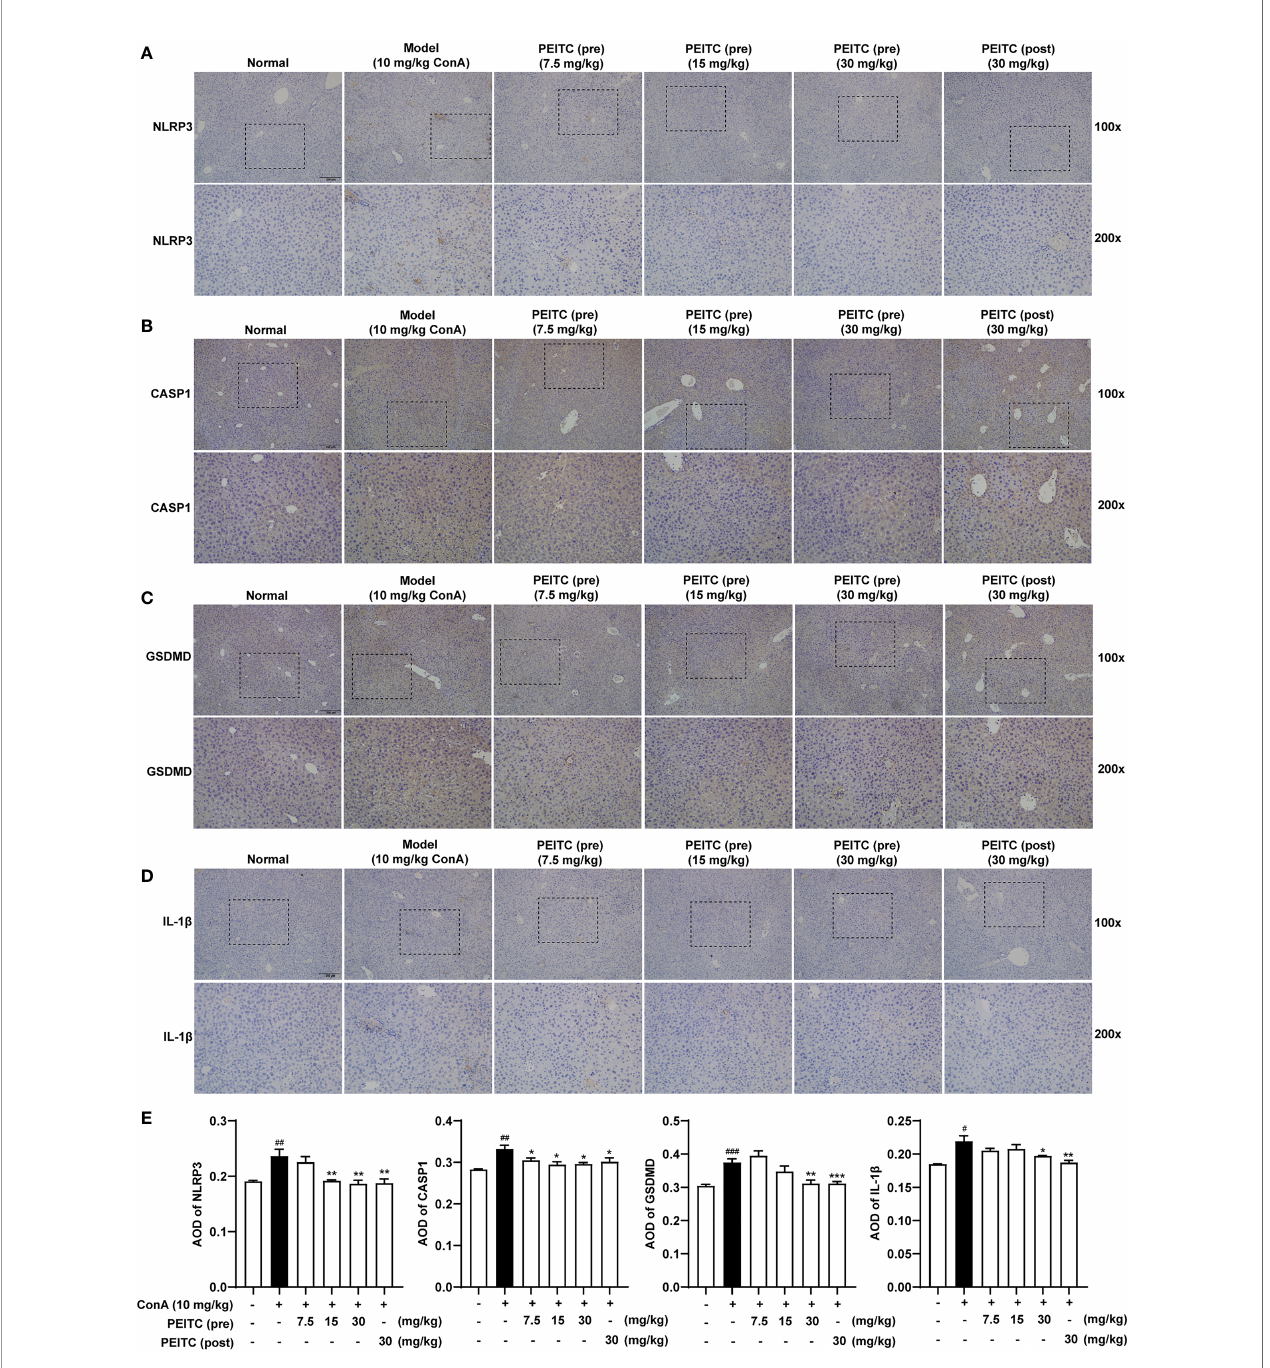
FIGURE 4 | PEITC reduced the expression levels of pyroptosis-related proteins. (A – D) Liver tissue sections from each group were stained for NLRP3, CASP1, GSDMD, and IL-1 b . Scale bar, 200 µm. (E) The average optical densities (AOD) of NLRP3, CASP1, GSDMD, and IL-1 b are displayed as histograms. Data are presented as means ± SEM ( n = 10 per group). # p < 0.05, ## p < 0.01, ### p < 0.001 vs. normal group, * p < 0.05, ** p < 0.01, *** p < 0.001 vs. ConA